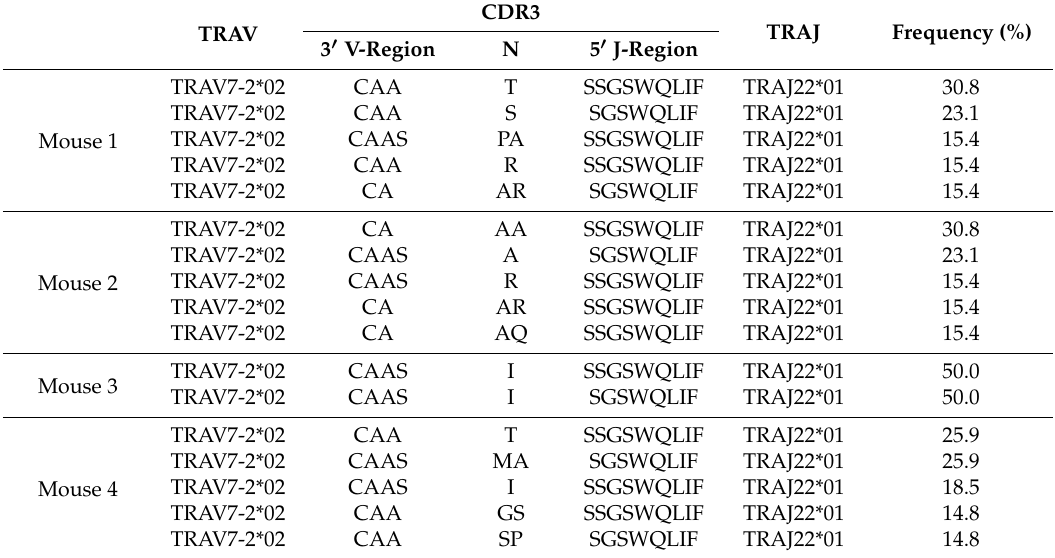
Table 3. The CDR3 amino acid sequences of TRAV7-2*02/TRAJ22*01 in mice given WT